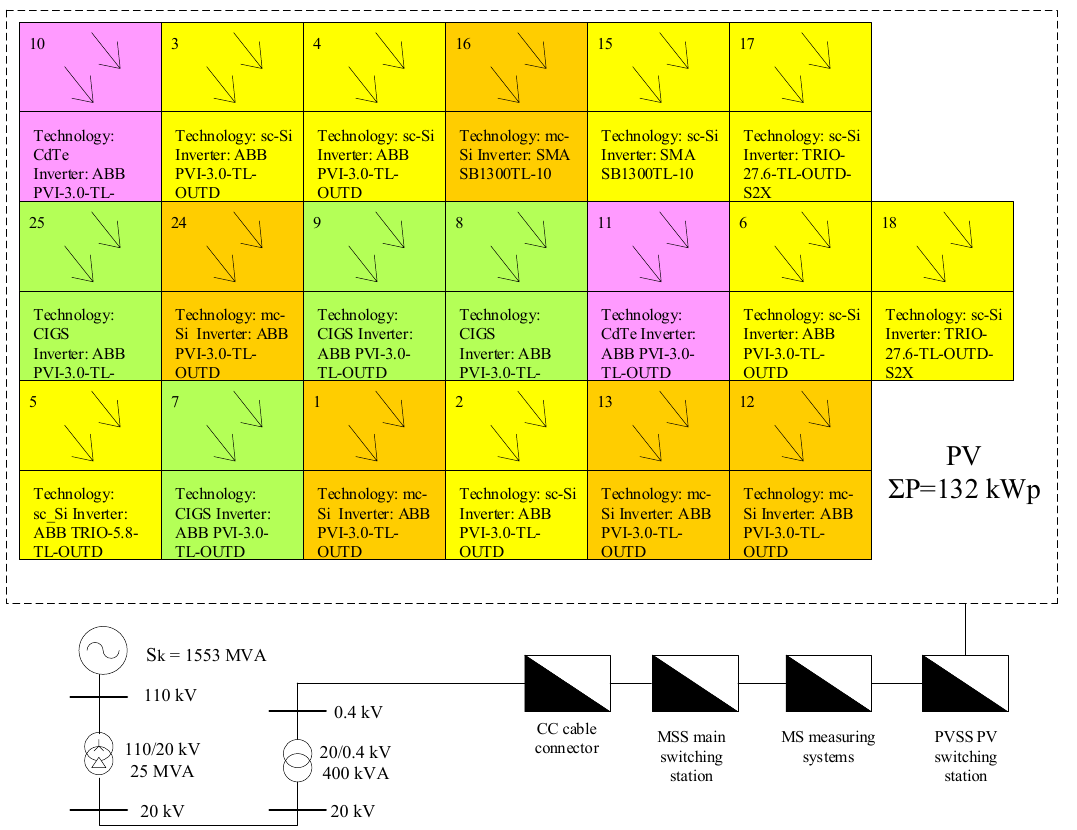
Figure 1. The diagram of investigated photovoltaic power plant with the assignment of rated power and photovoltaic (PV) technologies related to particular PV systems. Note: sc-Si—monocrystalline, mc-Si—multicrystalline, CdTe—Cadmium telluride cells, CIGS—Copper-Indium-Gallium-Diselenide, CC—connector cable, MSS—main switching station, MS—measuring system, PVSS—photovoltaic switching station